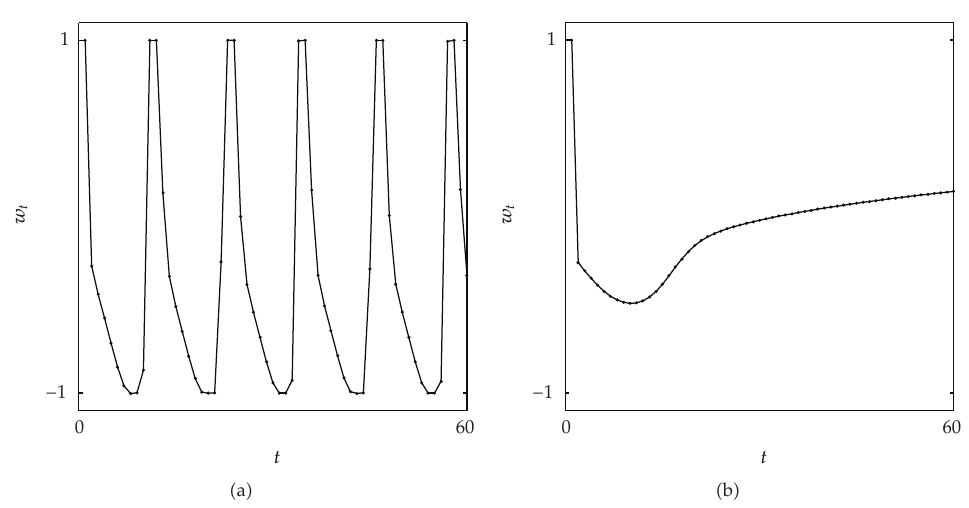
Figure 5: State variable w t versus time for an i.c. x 0 (cid:9) 0 . 8, m 0 (cid:9) 1 and w 0 (cid:9) 1 and parameter values α (cid:9) 0 . 5, λ (cid:9) 1, σ 2 (cid:9) 1, r (cid:9) 0 . 02, C (cid:9) 0 . 5, β (cid:9) 1. (cid:2) a (cid:3) a (cid:9) 0 . 1. Periodical fluctuations. (cid:2) b (cid:3) a (cid:9) 0 . 5.